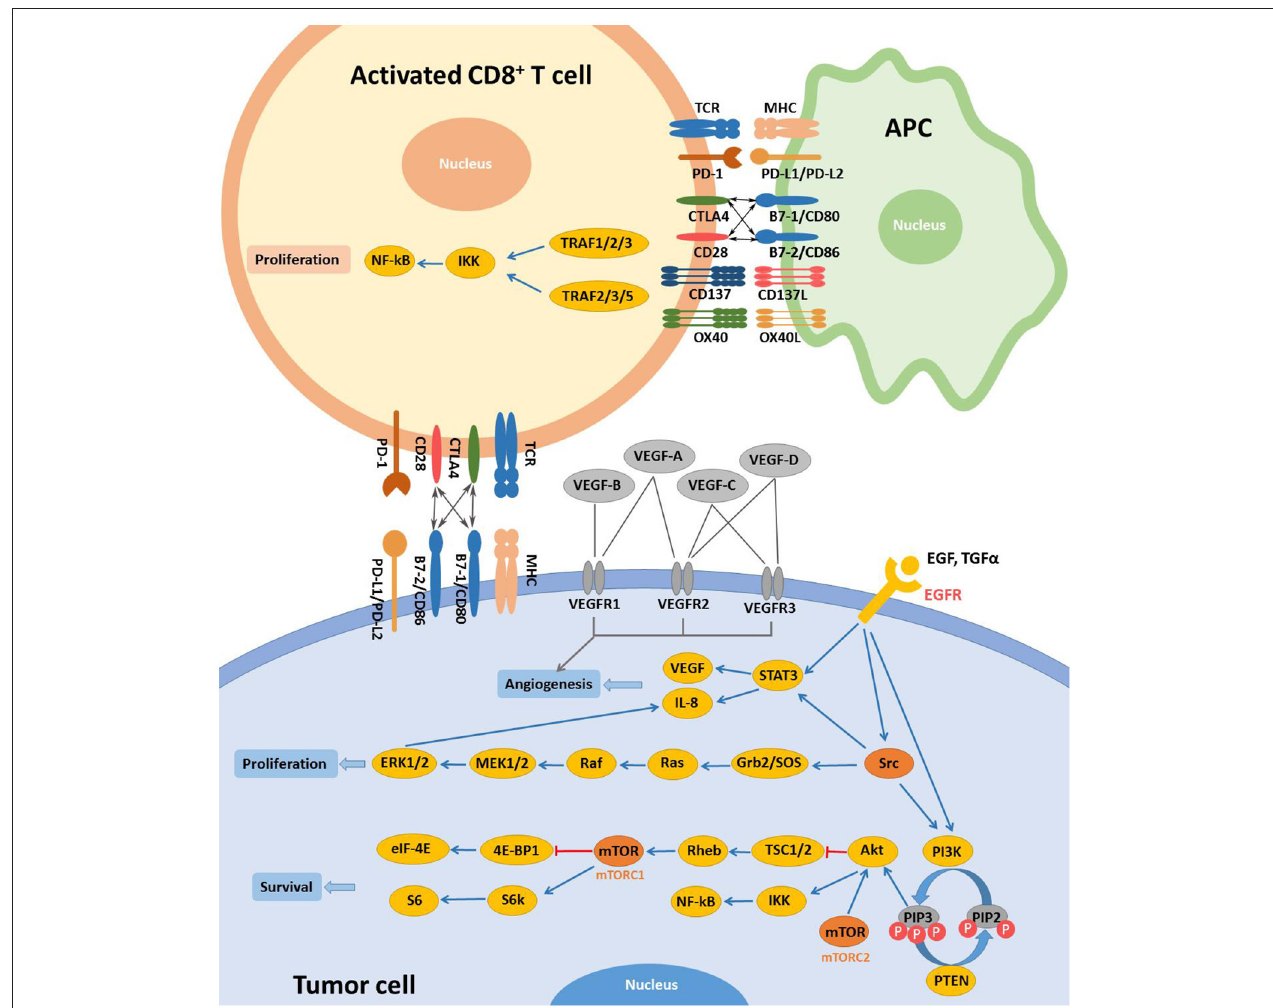
FIGURE 1 | Main targets and related signaling pathways involved in the targeted therapy for R/M HNSCC. Activation of EGFR by extracellular ligands initiates activation of Src, STAT3, and PI3K. Activated Src promotes cell proliferation mainly via RAS/RAF/MAPK pathway. In the PI3K/Akt pathway, phosphorylation of PIP2 is mediated by PI3K while dephosphorylation of PIP3 is controlled by PTEN. Akt could be activated independently by mTORC2 activation. Activation of Akt and mTORC1 inhibit TSC1/2/Rheb and 4E-BP1/eIF-4E downstream signaling, respectively while IKK/NF-kB and S6/S6k pathways are initiated, promoting tumor cell survival. Once activated, other targets, including VEGFR and c-MET, expressed on tumor cells share similar downstream signaling with EGFR. CD137L and OX40L activate CD137 and OX40, respectively. And proliferation of activated T cells is achieved via TRAF/IKK/NF- κ B downstream signaling. CTLA-4 and its ligands are also demonstrated. Some pathways were simplified for clearer